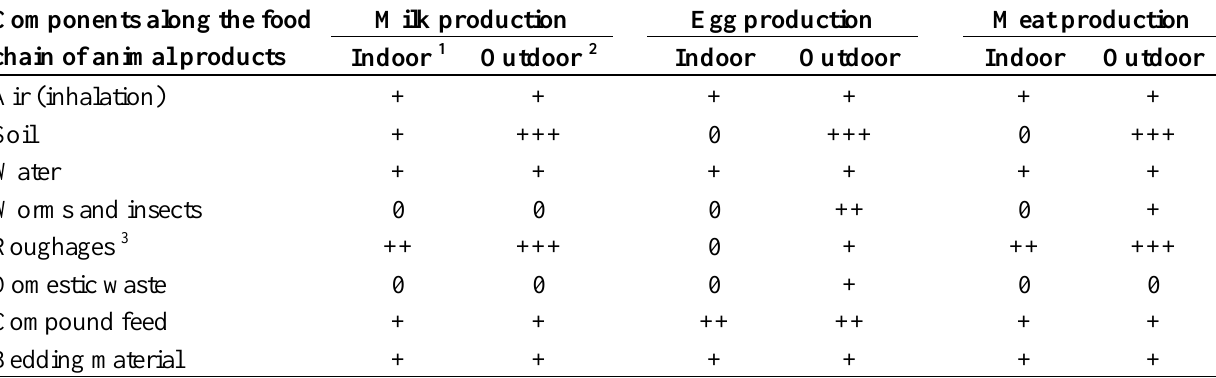
Table 2. Estimated magnitudes of contamination sources in milk, egg and meat production